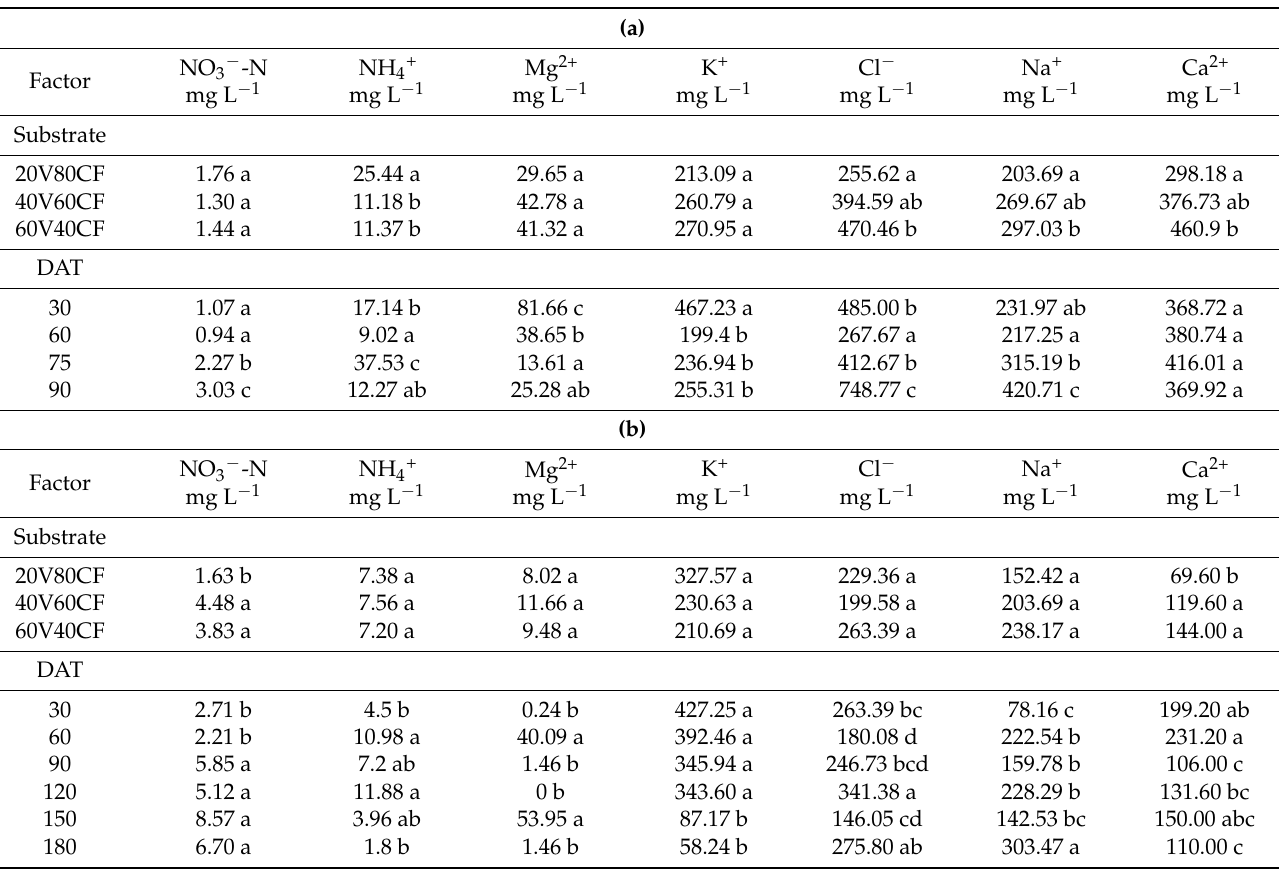
Table 8. ( a ) Concentrations of nutrients in drainage samples from the melon crop; ( b ) Concentrations of nutrients in drainage samples from the tomato